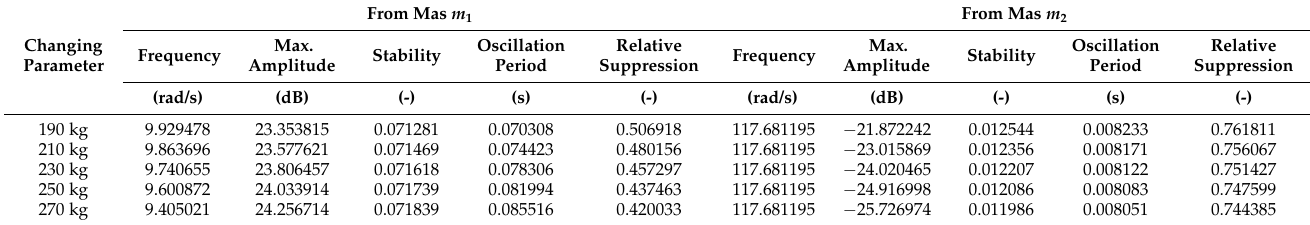
Figure 13. Amplitude and phase characteristics of the transmittance of the steering angle position when changing the value of the parameter m 2 . Table 6. The values of the parameters read from the graphs shown in Figure 12.